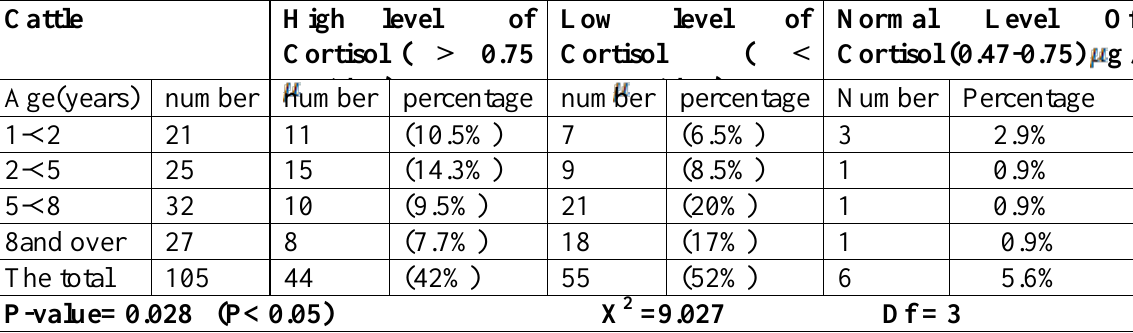
Table(2): RIA Result of cortisol